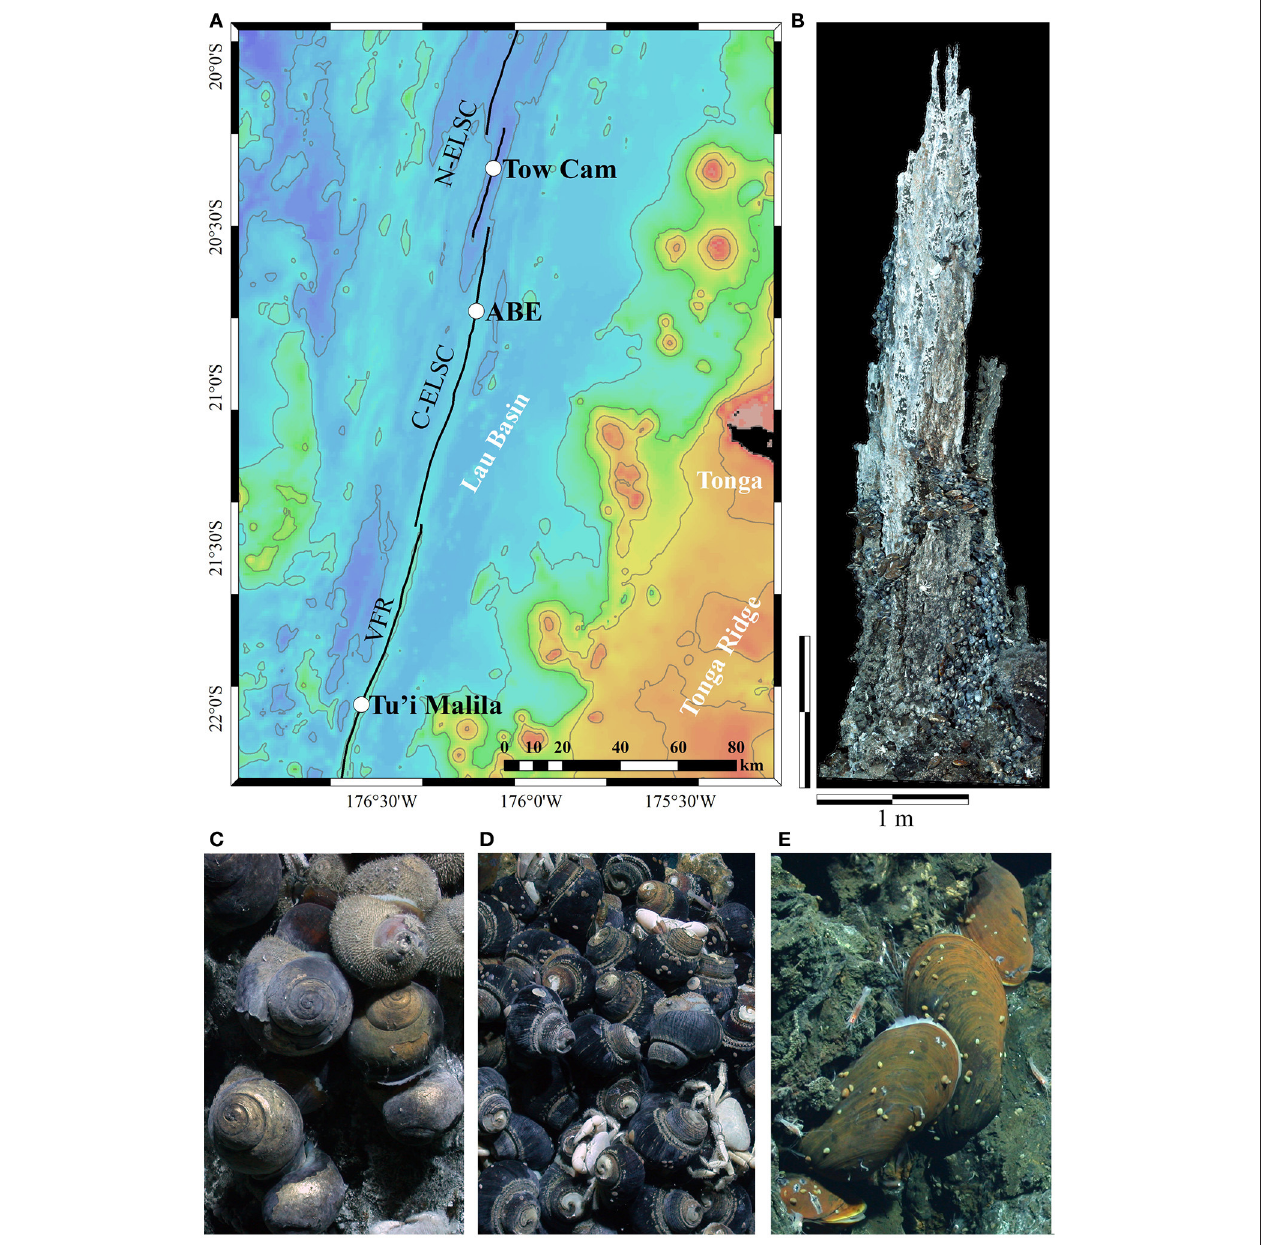
FIGURE 1 | The environmental settings of the study. (A) Our study sites are located within the Tongan region of the Lau Basin, along the North and Central Eastern Lau Spreading Center and the Valu Fa Ridge. The five hydrothermal vent edifices are within the Tow Cam, ABE, and Tu’i Malila vent fields. These vent fields are all located within deep-sea mining license blocks (see text for details). (B) This example high-resolution photo mosaic (ABE1C, 2016) shows the visual distinction between the lighter/white anhydrite summit deposits and the darker/grayish-brown sulfide base deposits, as well as the aggregated clusters of vent-associated fauna on the sulfide surfaces. The edifice sulfide deposits host three faunal groups of chemoautotrophic bacteria-containing invertebrates, (C) the provannid snails Alviniconcha spp. and (D) Ifremeria nautilei , and (E) mussel Bathymodiolus septemdierum .